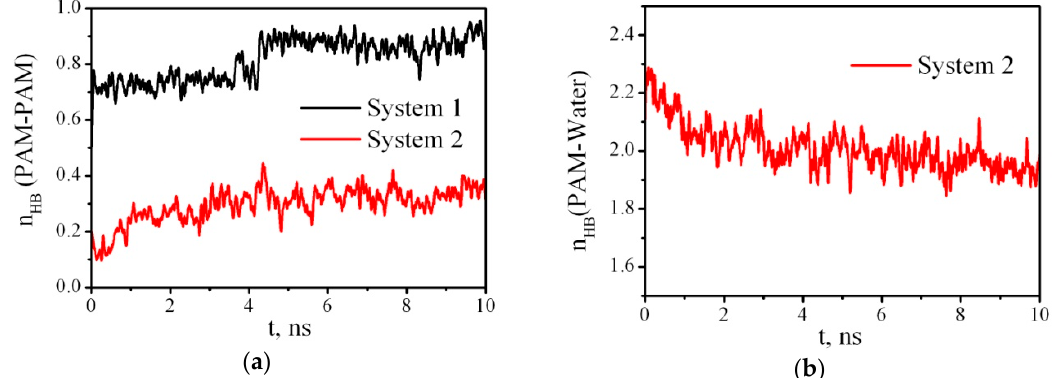
Figure 2. Time dependence of the radius of gyration of PAM ( a ) in a vacuum (System 1) and water (System 2), the snapshot of the PAM conformations in System 9 at the end of the simulation ( b ).